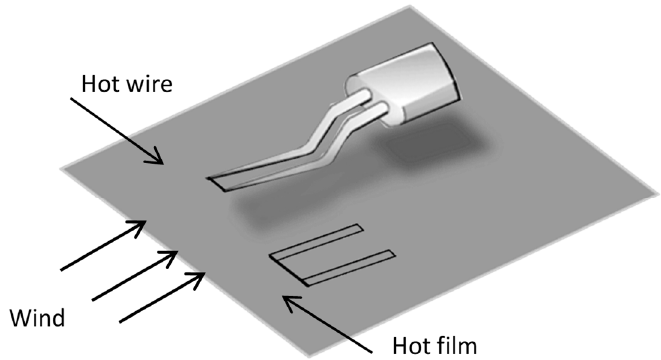
Figure 1. Hot wire and hot film used in the wind tunnel.